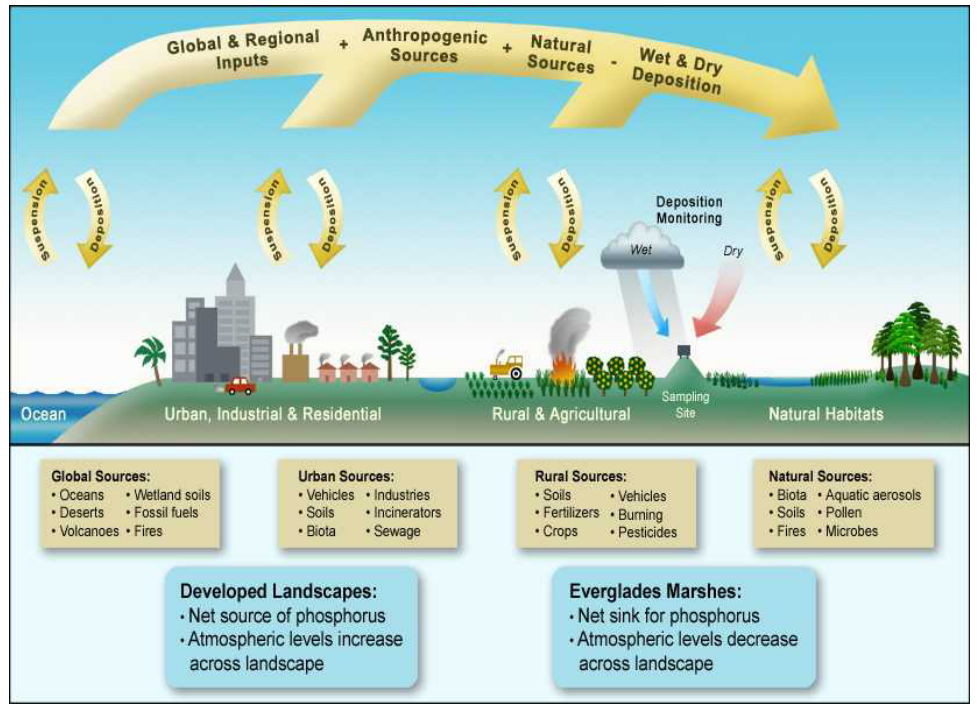
FIGURE 2. A conceptual model of the transport and deposition of phosphorus from the atmosphere. The landscape of South Florida (Fig. 1) is used for illustration, although sources, processes, and concepts can be applied to any